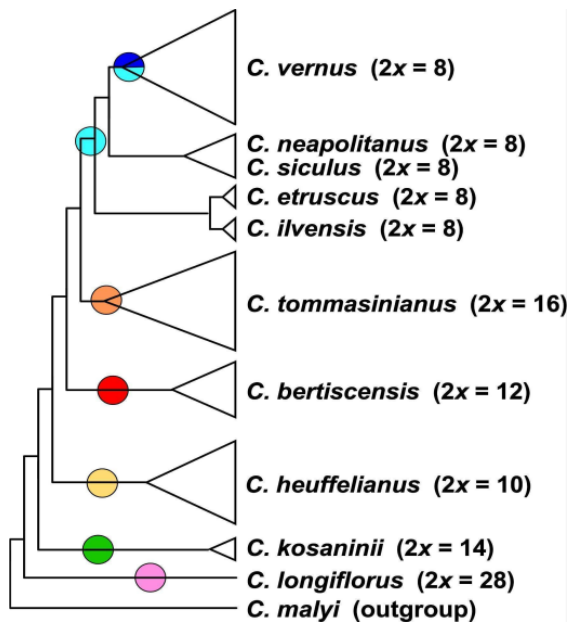
Figure 2. Schematic representation of the strict consensus tree topology of 45 most parsimonious trees derived from an MP analysis of the GBS dataset including only diploid accessions of Crocus ser. Verni (for original data see Supplementary Figure S2). In brackets, the ploidy levels and chromosome numbers are given. Colored circles refer to the chloroplast types present in the respective clades (below).